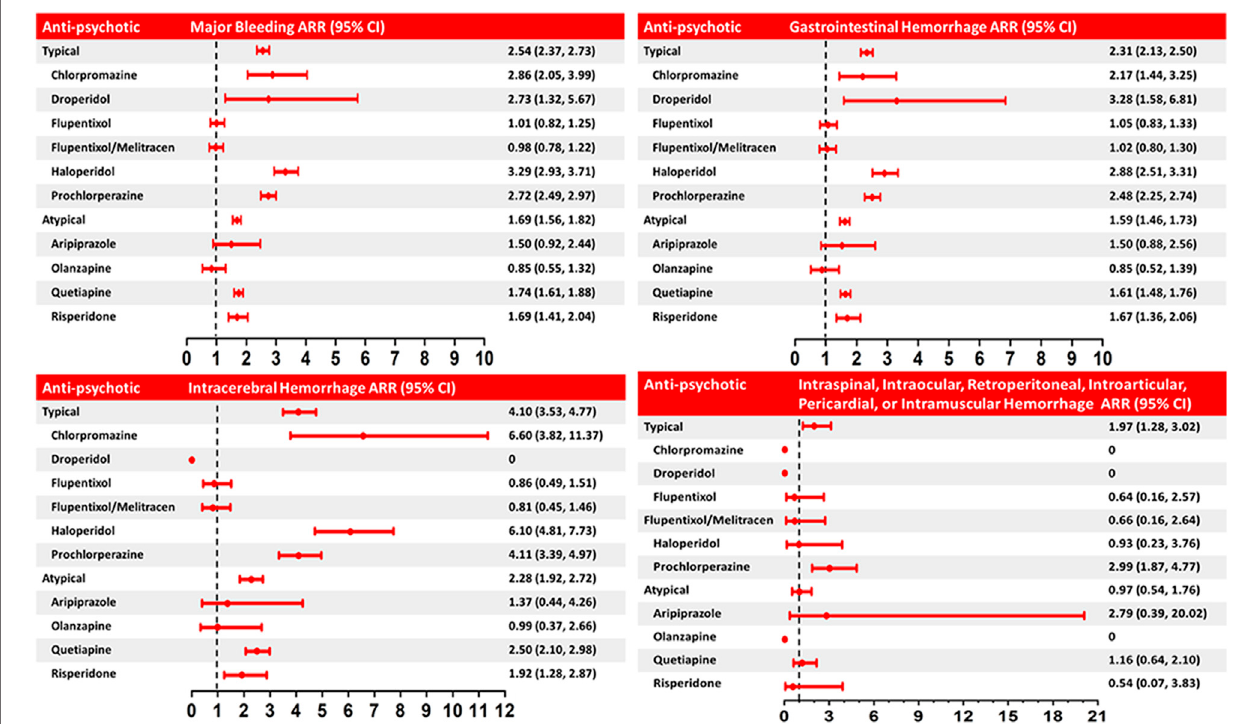
FIGURE 2 | Adjusted rate ratio (ARR) of major bleeding and intracerebral, gastrointestinal, intraspinal, intraocular, retroperitoneal, intra-articular, pericardial, or intramuscular hemorrhage associated with the concurrent use of NOACs and anti-psychotics (typical and atypical) versus use of NOACs alone. The rate ratio was adjusted by inverse probability of treatment weighting using the propensity score (covariates including demographics, comorbidities, medications, and expense of medical utilization, in Tables 1 , 2 and Supplementary Table S3 ). Horizontal lines represent 95% con fi dence intervals (CI).